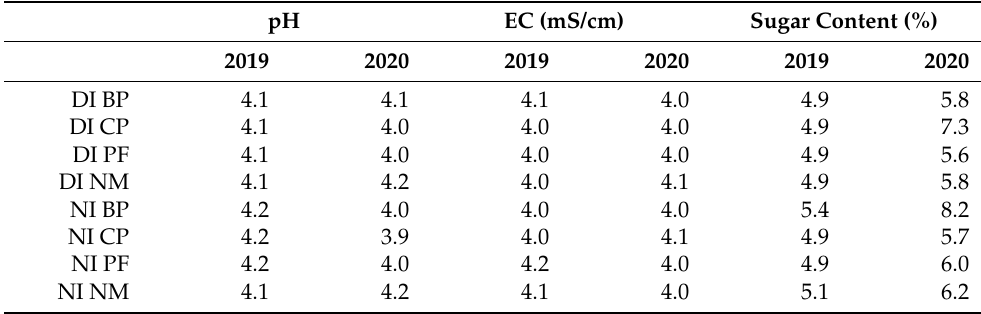
Table 8. Average quality parameters measured from watermelon samples collected during